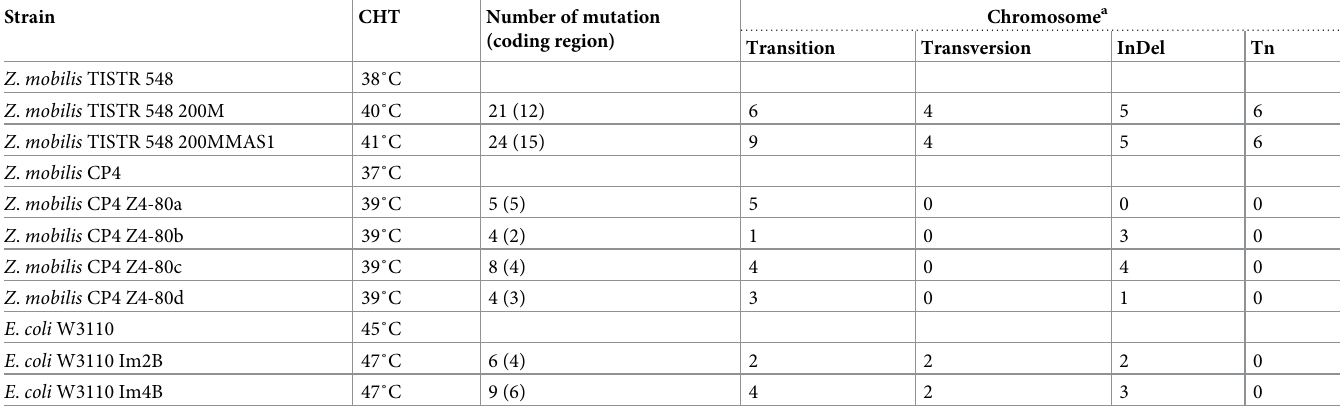
Table 1. CHTs and mutations of thermoadapted mutants.